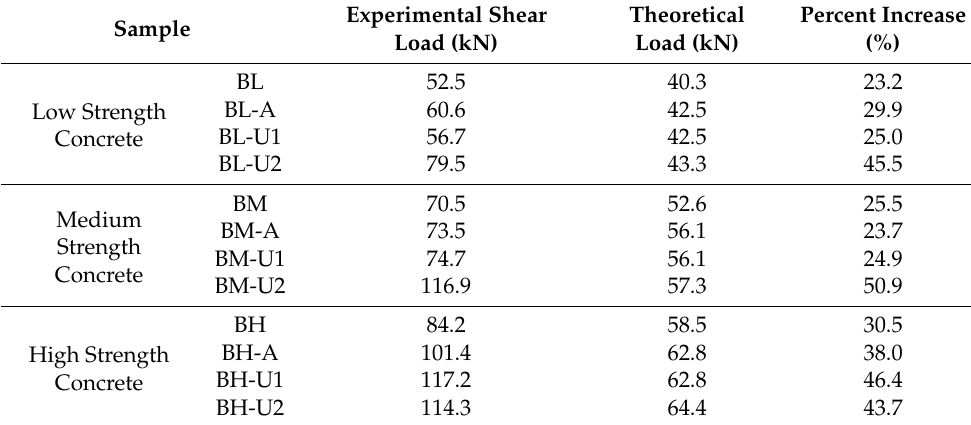
Table 4. Experimental and theoretical capacity results.